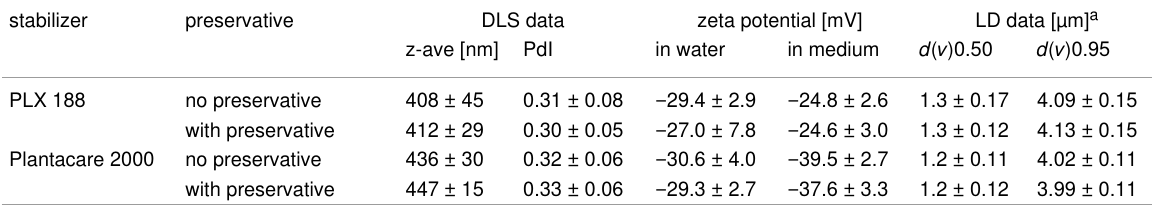
Table 1: Overview of results obtained from the characterization of the nanocrystals at the day of production.